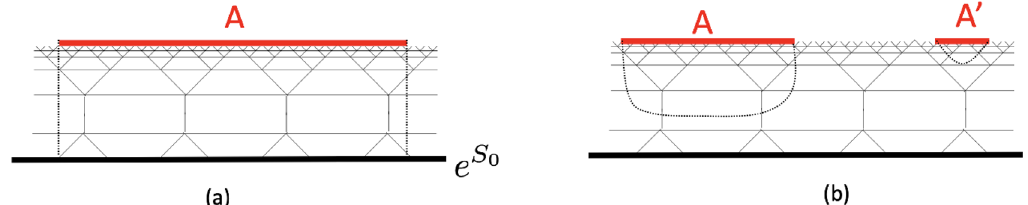
Figure 32 . Tensor network representation of the CFT state produced in the setup of section